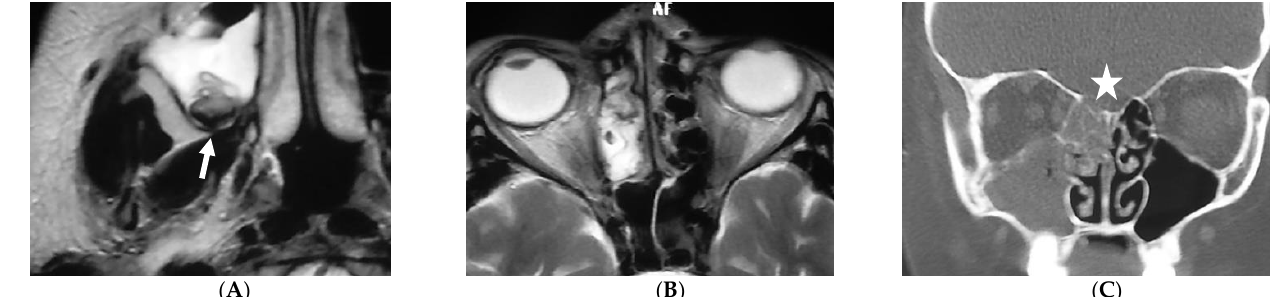
Figure 1. A 7-year-old girl with relapse of acute lymphoblastic leukemia (ALL) and biopsy-proven aspergillosis of paranasal sinuses. The patient has deceased. Axial T2-weighted magnetic resonance images (MRI) ( A and B ) show abnormal soft tissue filling the ethmoidal cells and in maxillary sinus on the right with T2-hypointensity (straight arrows). Coronal computerized tomography (CT) ( C ) shows destruction of the sinus walls and the cribriform plate (star) with extension into the anterior cranial fossa. Follow-up images (not shown) showed multiple parenchymal bleedings on the frontal lobes.